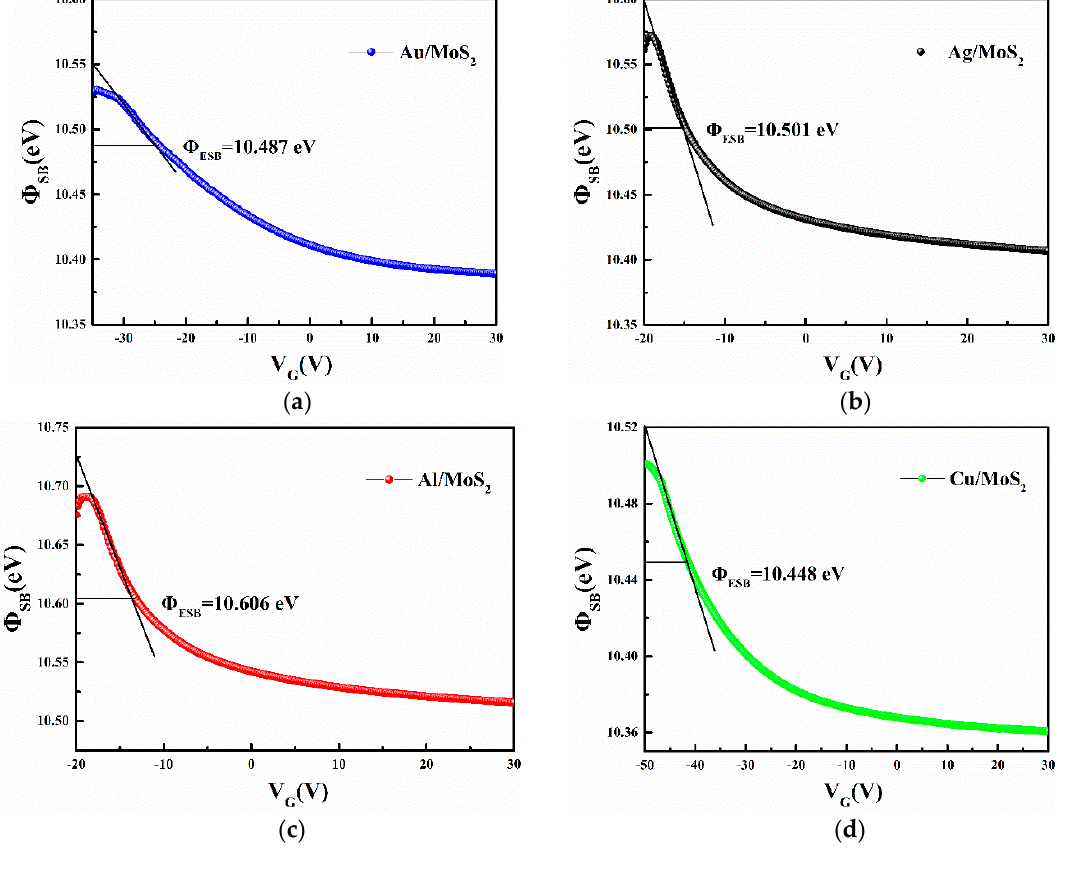
Figure 6. Barrier heights of MoS 2 -FETs constructed by electrode of ( a ) Au; ( b ) Ag; ( c ) Al;( d ) Cu.